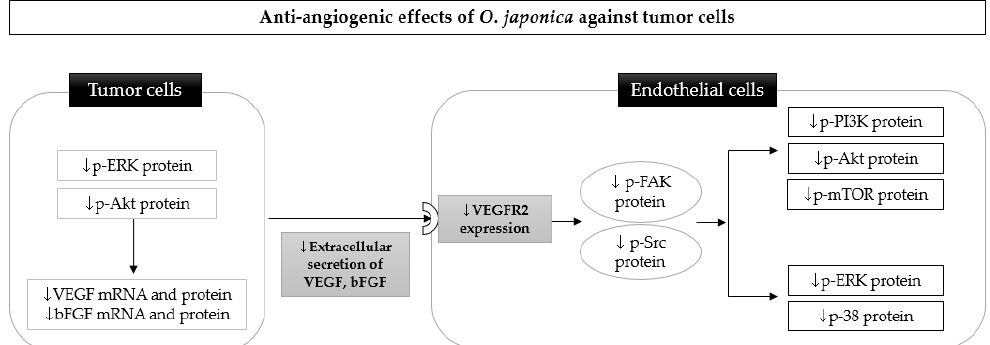
Figure 2. Possible molecular mechanism underlying the anti-angiogenic effects of Orostachys japonica against tumor cells, primarily, a blockade of the VEGF-VEGFR2 pathway. The downregulation of ERK and Akt by O. japonica in tumor cells results in the inhibition of VEGF and bFGF expression. The reduction of VEGF secretion from tumor cells by O. japonica can suppress the VEGF-VEGFR2 pathway in endothelial cells, thereby sequentially inhibiting phosphorylation of the FAK and Src, PI3K/Akt/mTOR, and MAPK pathways. ERK: extracellular signal-regulated kinases; Akt: protein kinase B; VEGF: vascular endothelial growth factor; bFGF: basic fibroblast growth factor; FAK: focal adhesion kinase; Src: proto-oncogene tyrosine-protein; PI3K: phosphoinositide 3-kinases; mTOR: mammalian target of rapamycin.